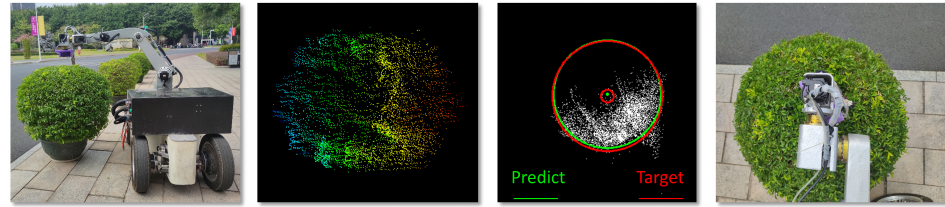
Figure 13. Visualization of the process of an experimental case in the testing